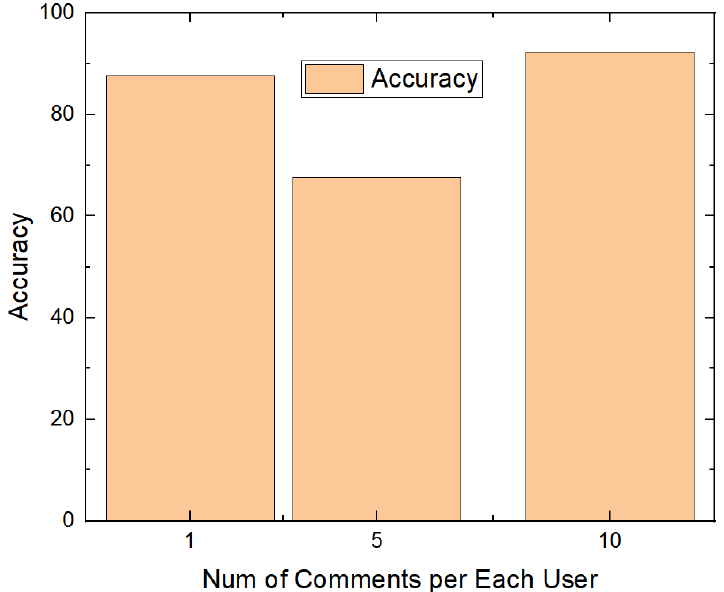
Figure 5. Accuracy of classifying each user’s political stance using Seq2Seq.